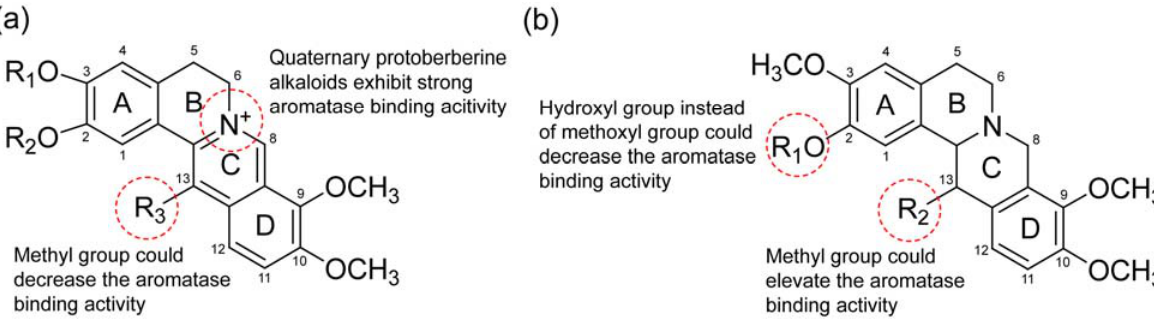
dichloromethane extract of C. yanhusuo